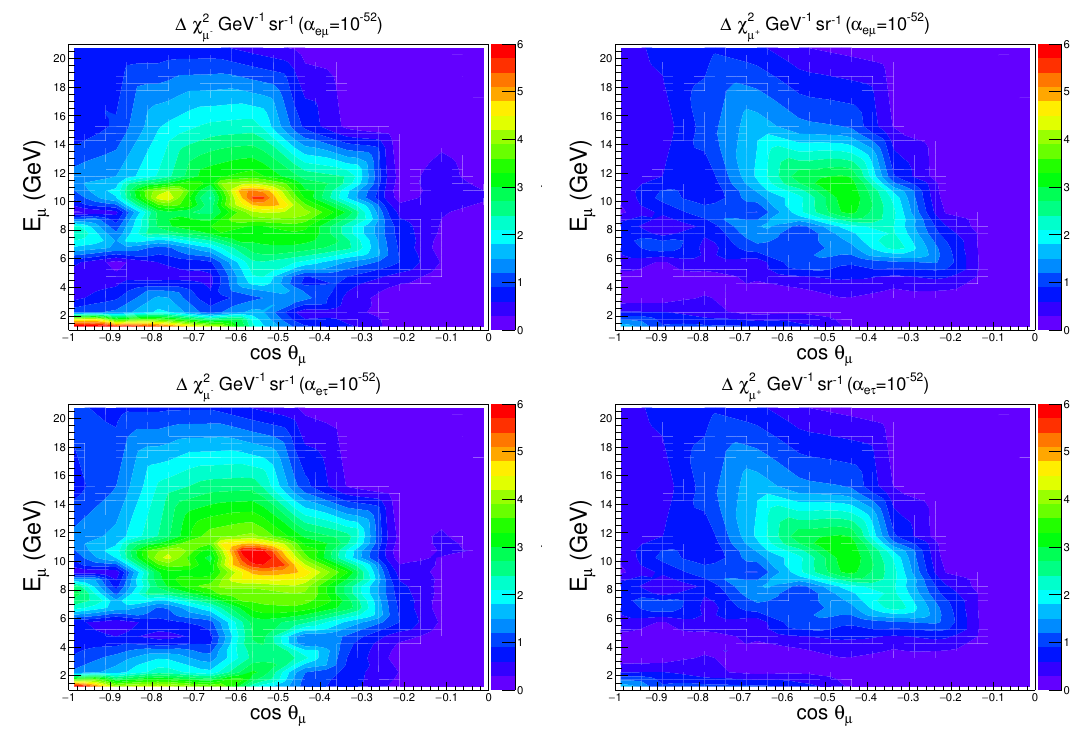
Figure 10 . Distributions of (cid:1) (cid:31) 2 (per unit area) in E (cid:22) and cos (cid:18) (cid:22) plane. The left (right) ICAL (cid:0) LRF panels are for (cid:22) (cid:0) ( (cid:22) + ) events. In upper (lower) panels, we assume non-zero (cid:11) e(cid:22) ( (cid:11) e(cid:28) ) in the (cid:12)t with a strength of 10 (cid:0) 52 . In all the panels, we use 500 kt (cid:1) yr exposure and assume NH in both data and